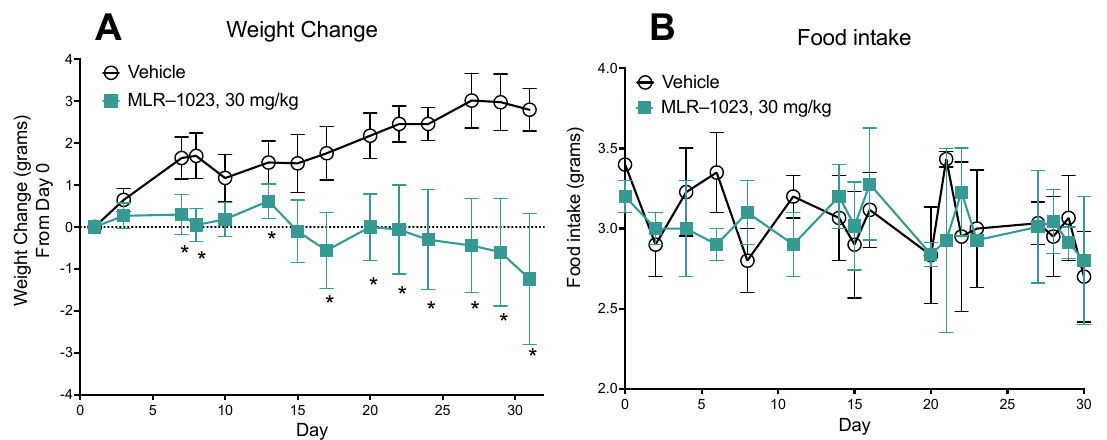
Figure 1. Effect of 30 mg/kg of MLR-1023 twice daily on body weight and food intake in CD1/ICR mice. The mice were weighed daily, and food intake was monitored every one to four days. ( A ) Weight change from day 0 to day 31 ( B ) Food intake from day 1 to day 31. N = 6 per group. Values are mean ± SEM. * p <